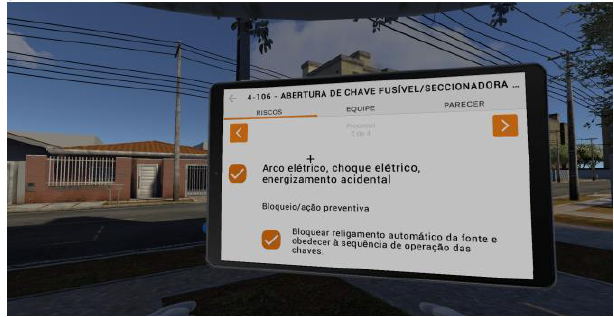
Figure 23. Filling the PRA form in the Virtual Tablet.